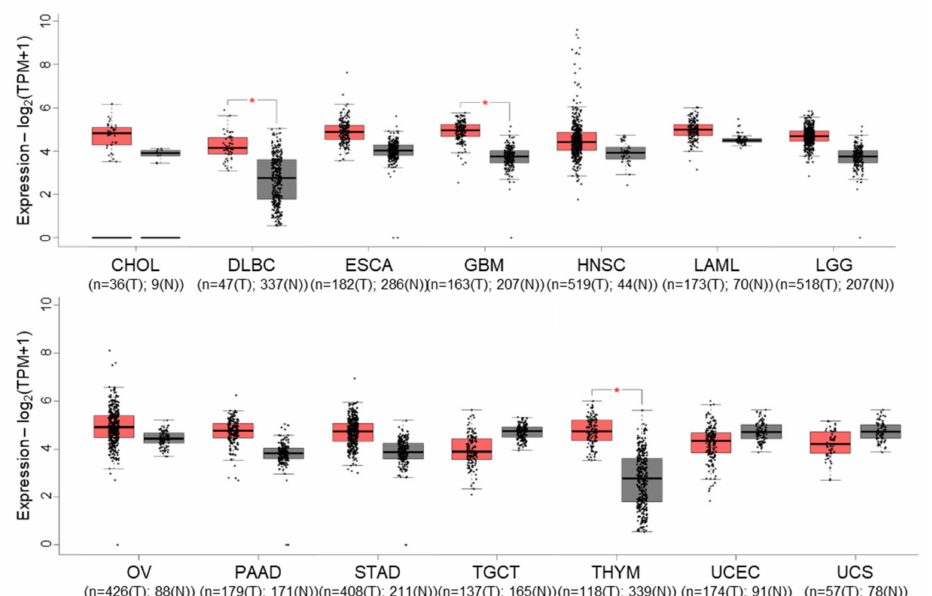
Figure 3. Gene expression profile interactive analysis (GEPIA) of BIRC2 (cIAP1-encoding gene) in tumors (T, red)) and normal (N, grey) samples from the cancer genome atlas (TCGA) project. Only results showing a difference in BIRC2 expression between cancer and normal samples are